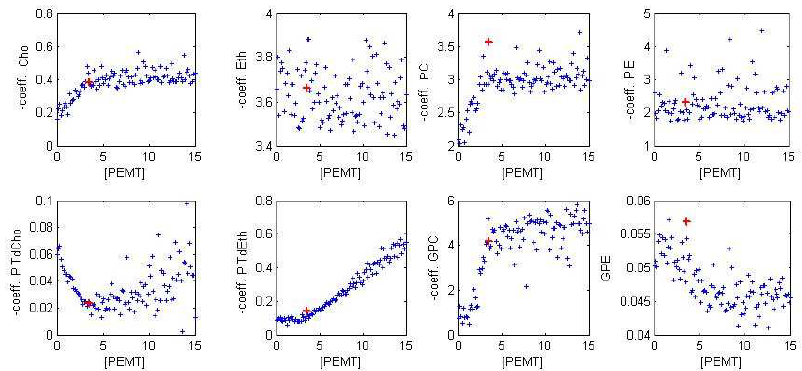
Figure 5: Speed Analysis. -k (Rate Coefficients) vs. Concentration of enzyme PEMT(real val- ues). The red point on each diagram is associated to rate coefficient at the steady state of the experimental values. Concentrations values are given in µmol.g − 1 .